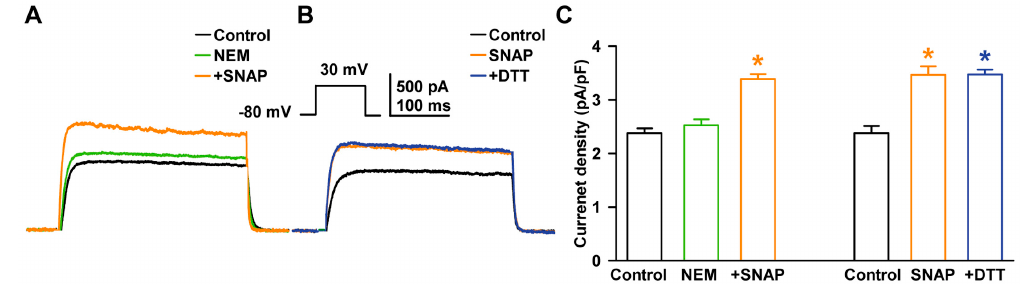
Figure 7. Influence of S -nitrosylation on the stimulating effect of NO on I K . ( A ) Representative currents showing the effect of SNAP on I K after pretreatment with N-ethylmaleimide (NEM). ( B ) Effect of DL-dithiothreitol (DTT) on SNAP-stimulating I K . ( C ) Bar graph summarizing current density changes for SNAP effects on I K after pretreatment with NEM and DTT. * p < 0.05 versus the control.